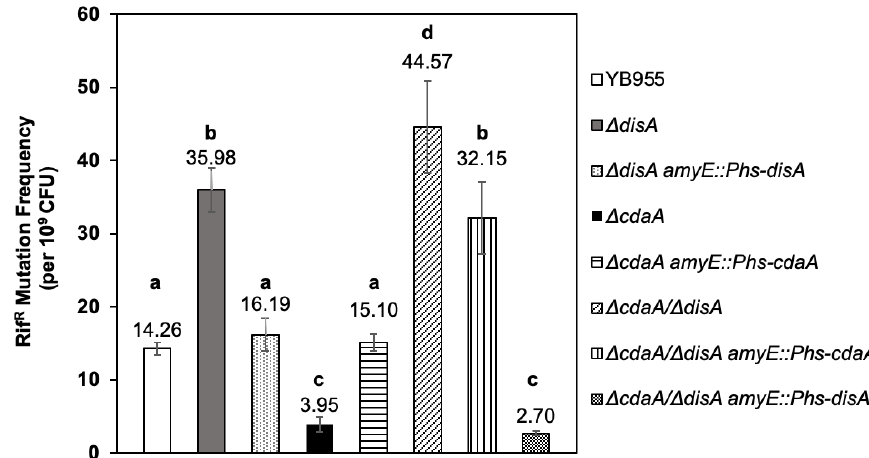
Figure 3. Hydrogen peroxide induced mutation frequencies to rifampicin resistance (Rif R ) of Bacillus subtilis YB955 (open bar), Δ disA (dark grey bar), Δ cdaA (black bar) and Δ cdaA /Δ disA (hatched bar) were determined during exponential growth. Complemented strains Δ disA amyE:: P hs-disA (light stippled bar), Δ cdaA amyE:: P hs-cdaA (horizontal striped bar), Δ cdaA /Δ disA amyE:: P hs-cdaA (vertical striped bar), and Δ cdaA /Δ disA amyE:: P hs-disA (dark stippled bar) were also tested. Data show the average from three independent experiments, each one by sextuplicate ± standard deviations. All strains were supplemented with IPTG 0.25 mM. Different letters (a, b, c, d) represent significant statistical differences between means, the same letter denotes no significant difference, as determined by a one-way ANOVA and multiple mean comparison by Tukey HSD test (all p -values < 0.001).